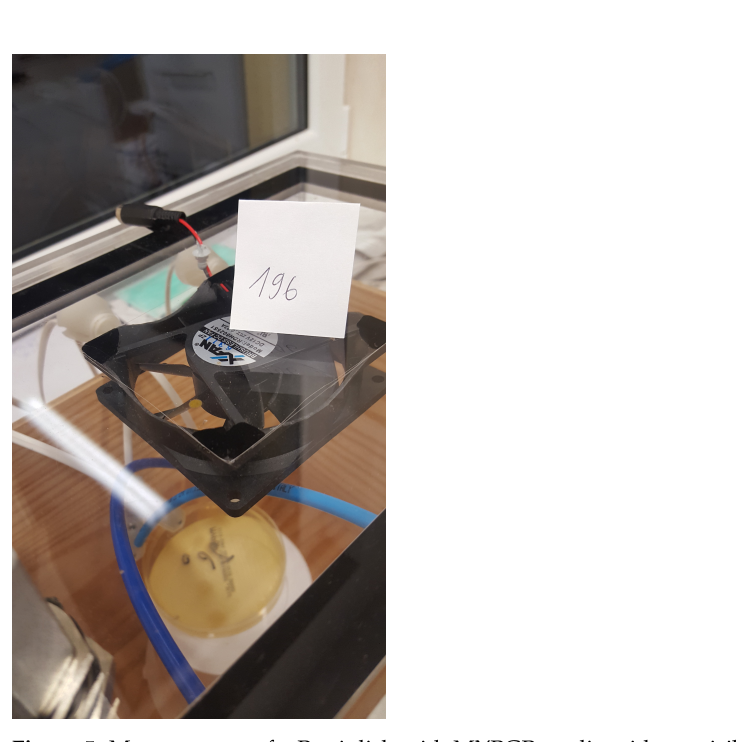
Figure 5. Measurement of a Petri dish with MYPGP media without visible colonies (class 23) in a wooden chamber.